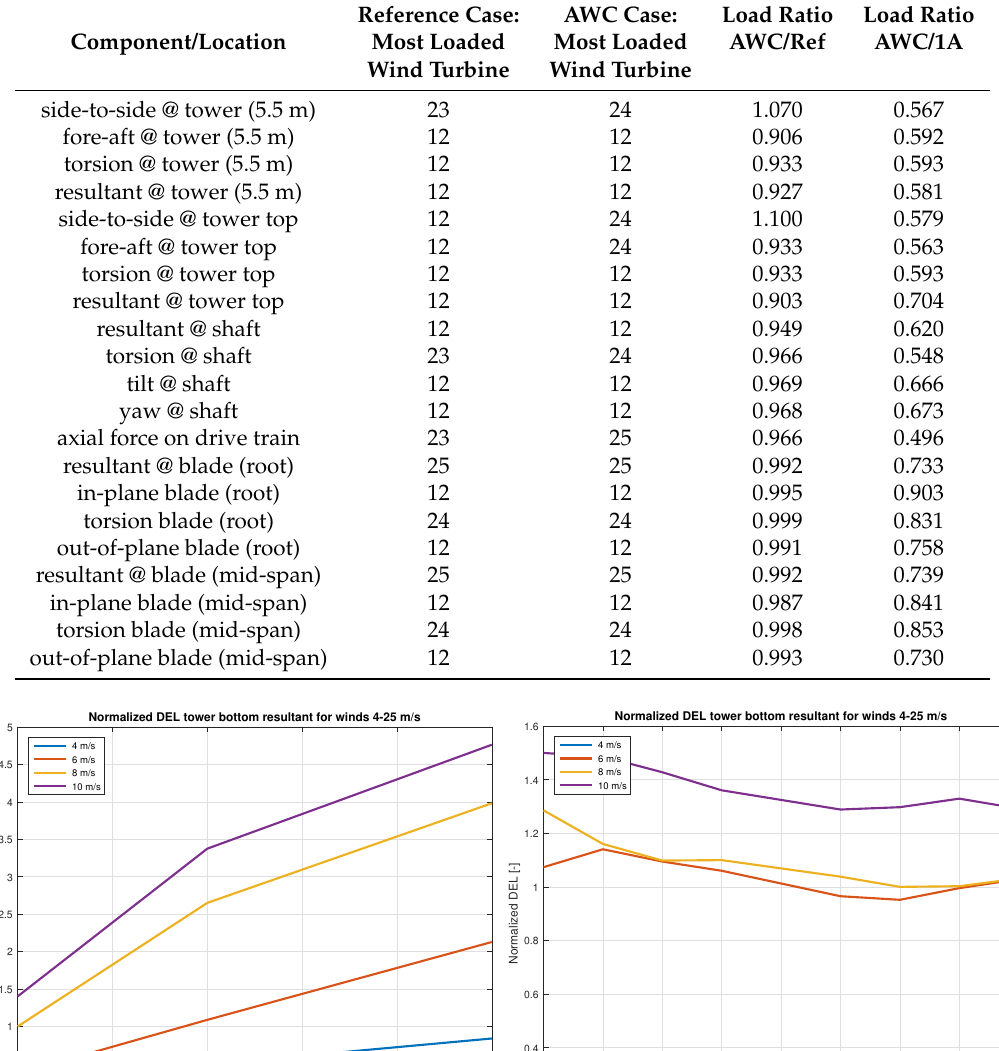
Table 3. Lifetime fatigue loads per component for wake redirection.